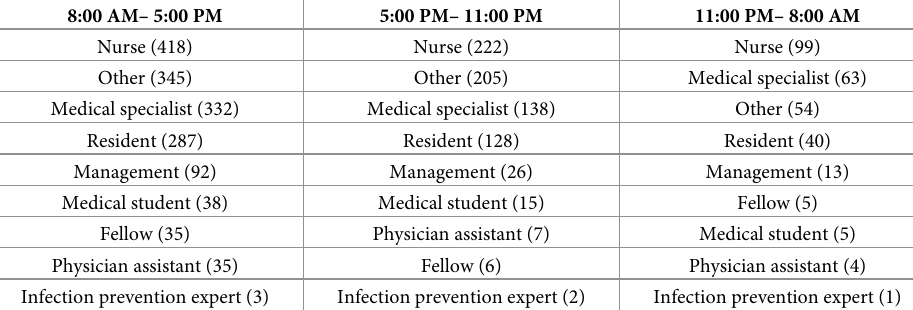
Table 1. Number of sessions per role per time of